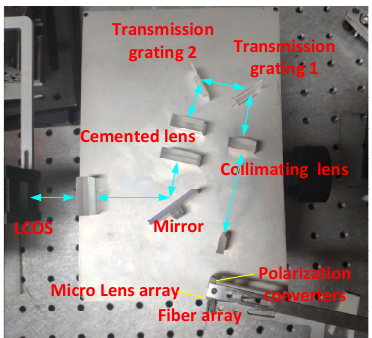
Figure 4. Experimental site using our proposed low-cost compact spatial light paths. All the optical elements are solidified on an optical substrate.